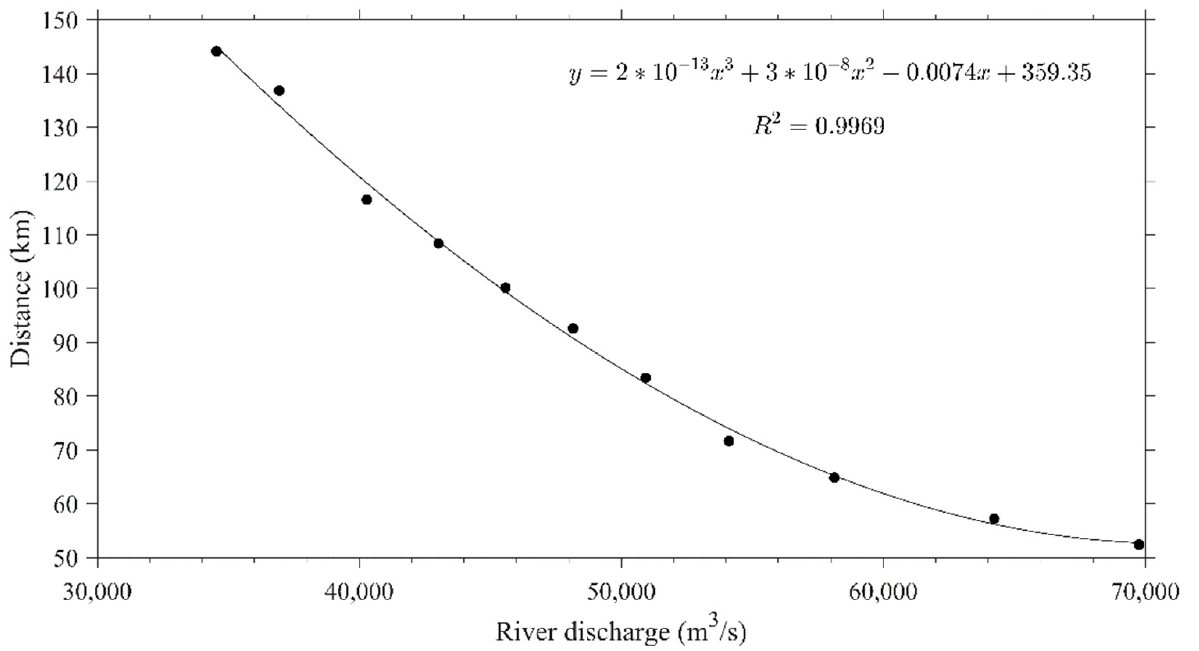
Figure 5. Relationship between the tidal current limit and the river discharge in the Changjiang River’s estuary in the flood season.